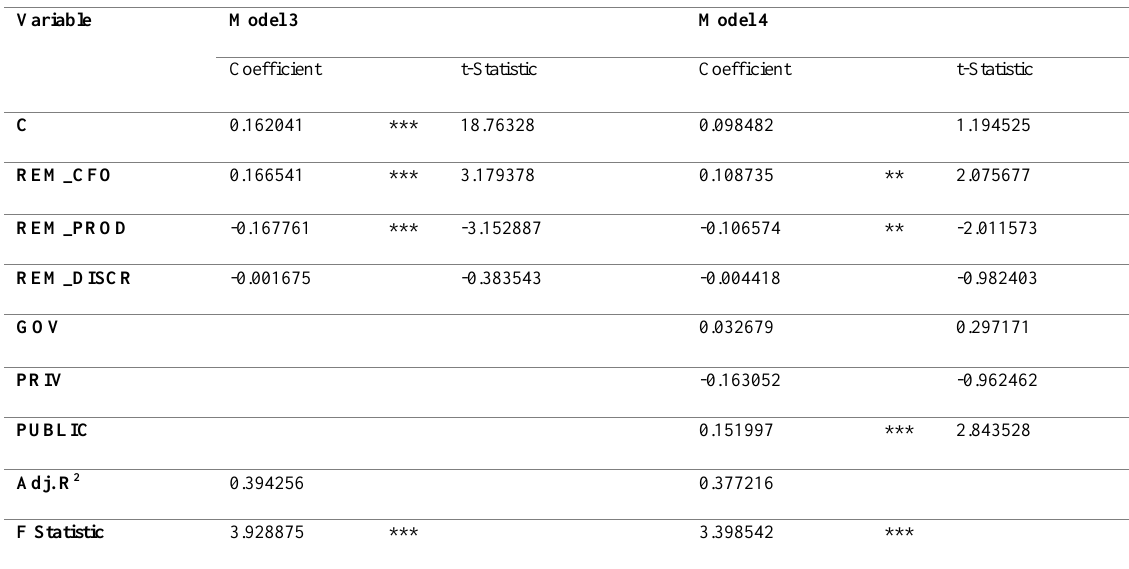
Table 4: Regression